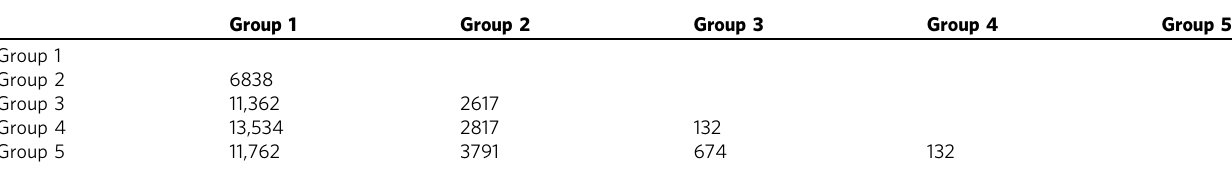
Table 1 Number of signature SNP sites on which major alleles were different between a pair of tea